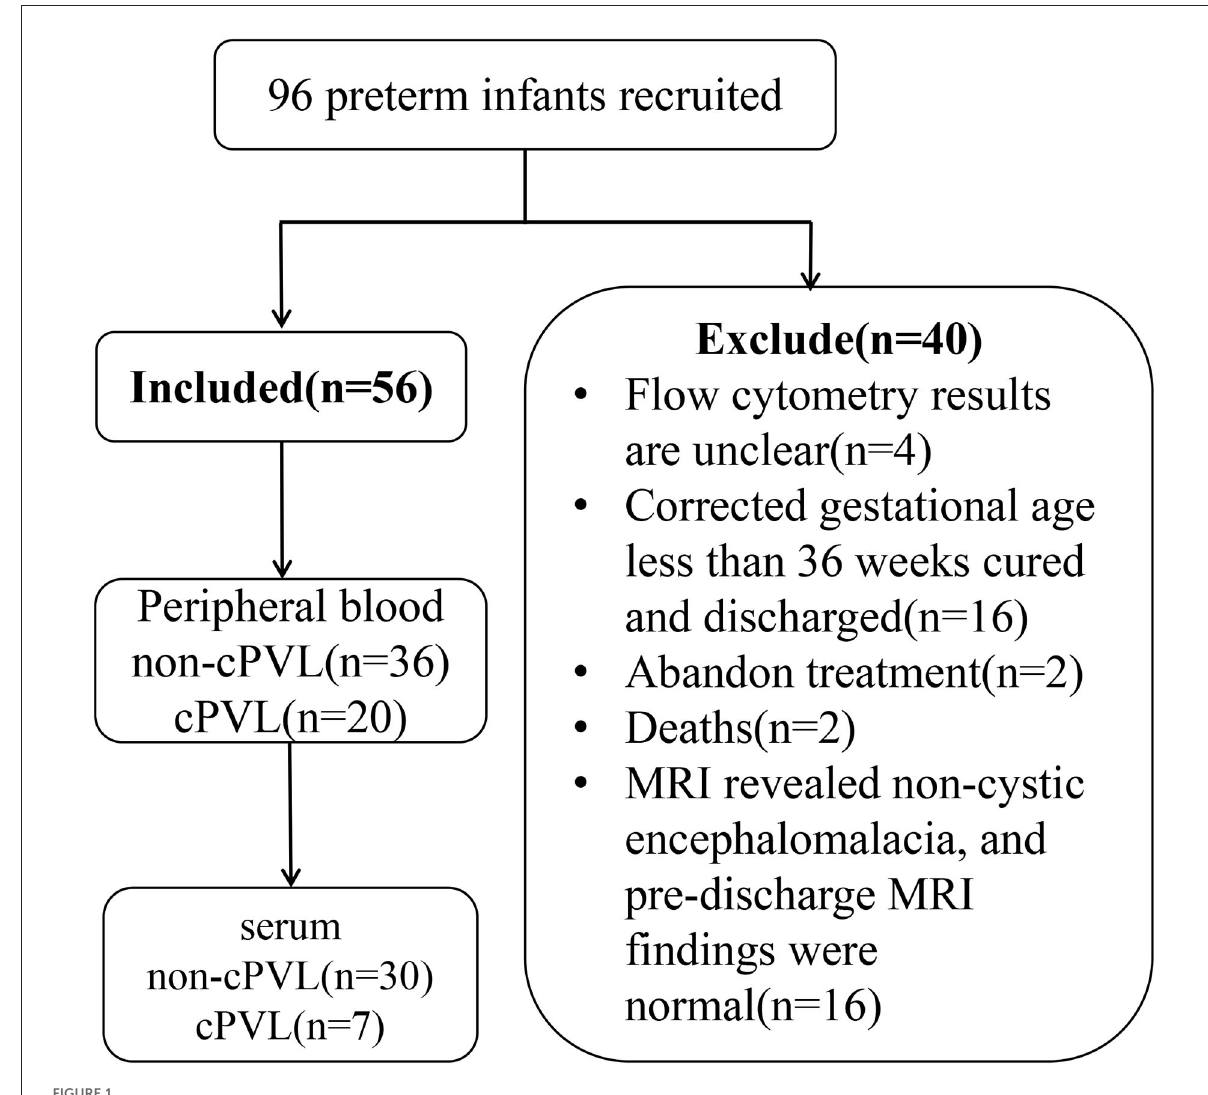
FIGURE1 Flow chart of the study participants. cPVL, cystic peripheral ventricular